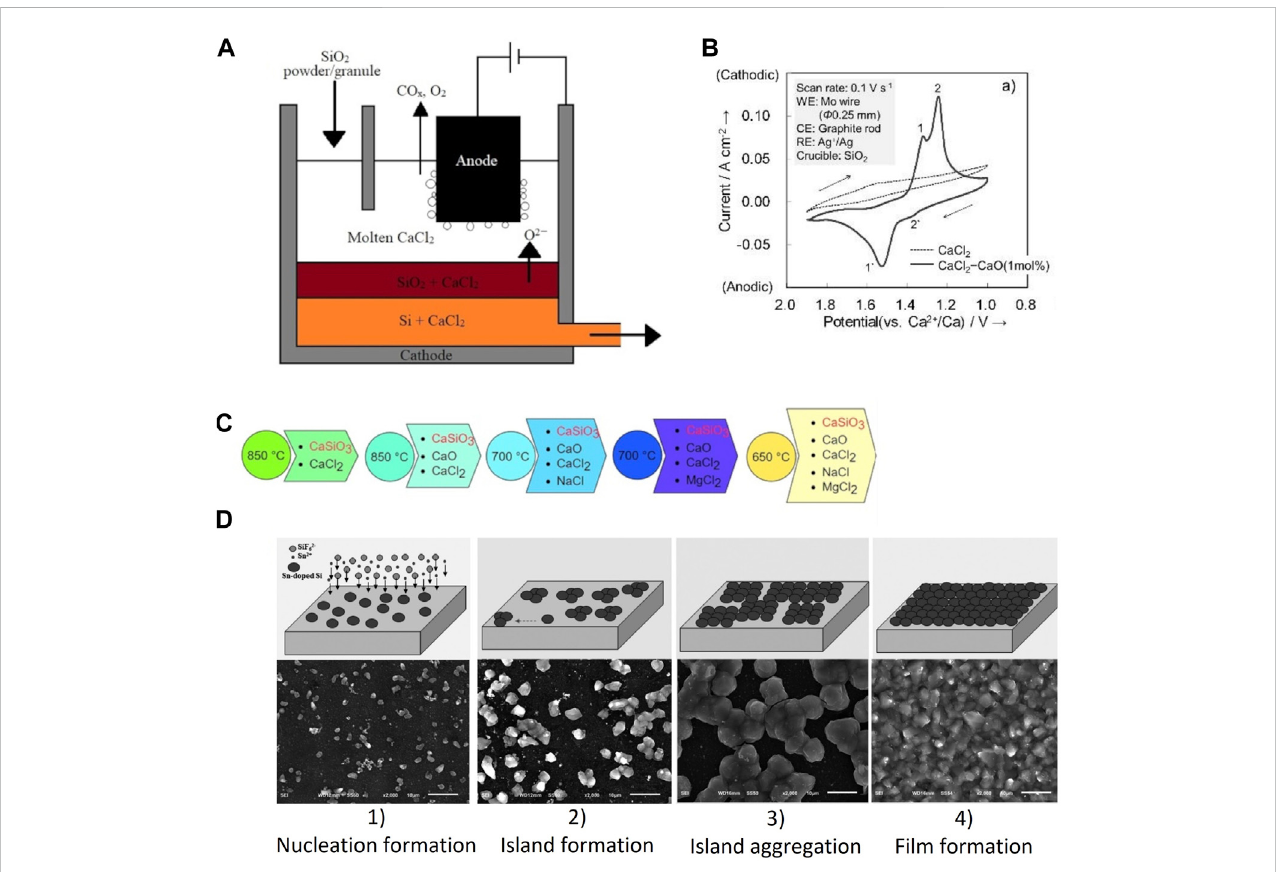
FIGURE 1 (A) The principle of the bottom cathode cell for the semi-continuous electrolysis of SiO (B) Cyclic 2 powder (redrawn from Toba et al., 2013), voltammograms of a Mo wire in molten CaCl 2 and CaCl 2 − CaO (1 mol%) in a SiO 2 crucible at 1,123 ° C (reused with permission from Yang et al., 2017), (C) The progression of reaction designs that led to the fi nal ef fi cient low-temperature electrochemical reduction of CaSiO 3 precursor (redrawn from Dong et al., 2017), (D) Schematic representation of growth process of tin-doped silicon fi lm from electrodeposition on graphite foil substrate at 650 ° C in KCl – KF-1 mol% K 2 SiF 6 salt with 0.02 wt% Sn dopant and corresponding morphologies of samples with different time at 5 mA cm − 2 : 1) nucleation, in 5 min; 2) island formation, in 15 min; 3) island aggregation, in 30 min; 4) fi lm formation, more than 90 min (reused with permission from Peng et al.,